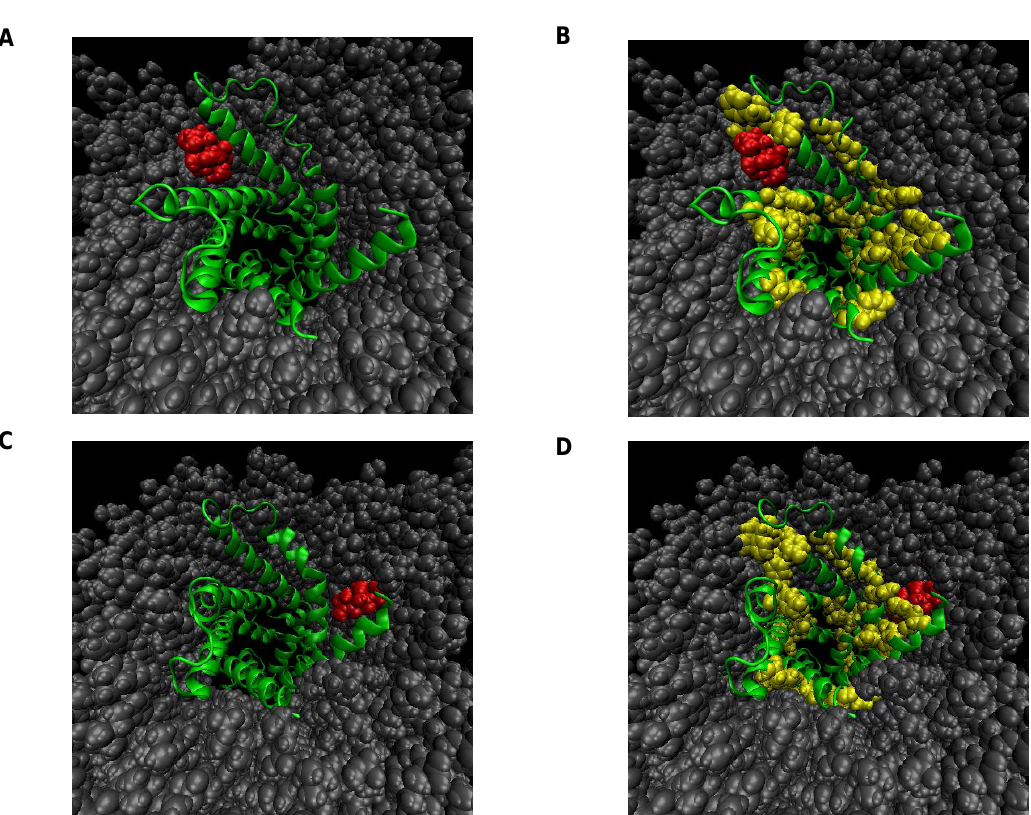
Figure 4. Molecular binding models for the interaction between rabdosianone I with ANT2 in the membrane. ( A ) Most populated complex structure of rabdosianone I with ANT2. ( B ) Emphasis of aromatic residues in A . ( C ) Secondary populated complex structure of rabdosianone I with ANT2. ( D ) Emphasis of aromatic residues in C . The structure of bovine mitochondrial ADP/ATP carrier (PDBcode:1OKC) with high sequence identity (90.07%) was used as a template for homology modeling. The Figures were made by PyMOL (The PyMOL Molecular Graphics System, Version 2.0 Schrödinger, LLC.). Color shows ANT2 (green), aromatic residues (yellow), rabdosianone I (red), and POPC lipid (gray).